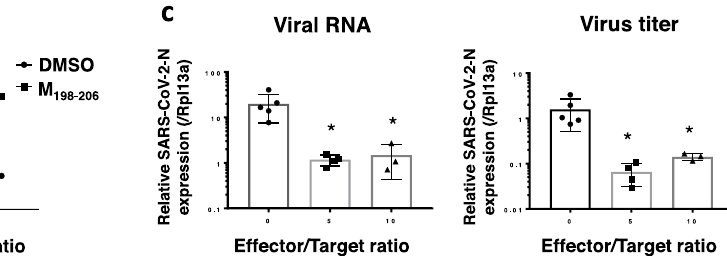
at 24h after infection. After a further 24h incubation, cells were washed and har- vested. Intracellular viral RNA was measured by quantitative real-time PCR using a primerpair targeting the SARS-CoV-2 N generegion. The titerofinfectious virusin the supernatant was measured based on the amount of intracellular viral RNA in VeroE6/TMPRSS2 cells infected with virus-containing supernatant from Calu-3 cells. The expression level of viral RNA was normalized to host rpl13a expression. Data represent mean±SD ( n =5, 4, and 3 for E/T=0, 5, and 10, individually). p values werecalculated bytwo-sidedMann – Whitney test. * p =0.016, 0.036 for viral RNA; * p =0.016, 0.036 for virus